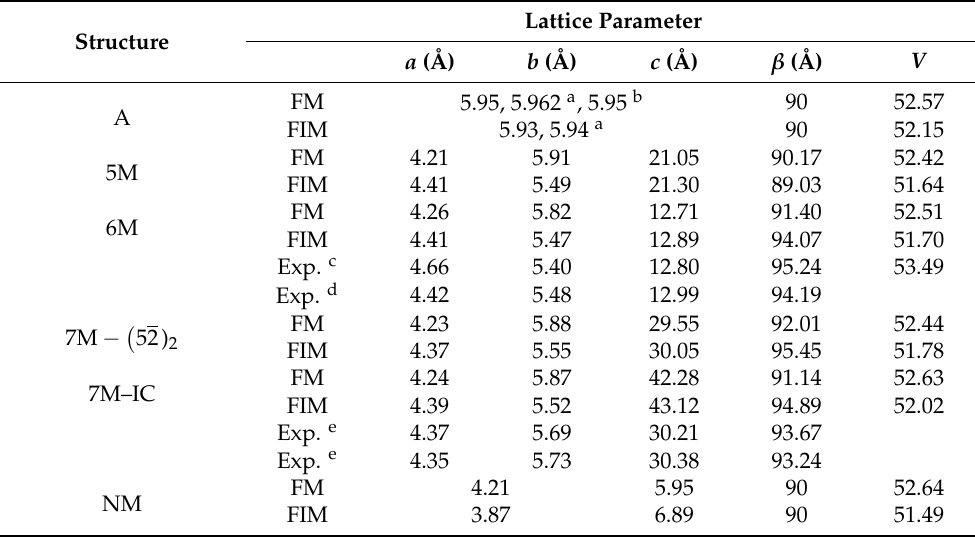
Table 1. Theoretical lattice parameters of possible phases of Ni 2 Mn 1.5 In 0.5 alloy in FM and FIM states in comparison with experimental or other theoretical data. Structure